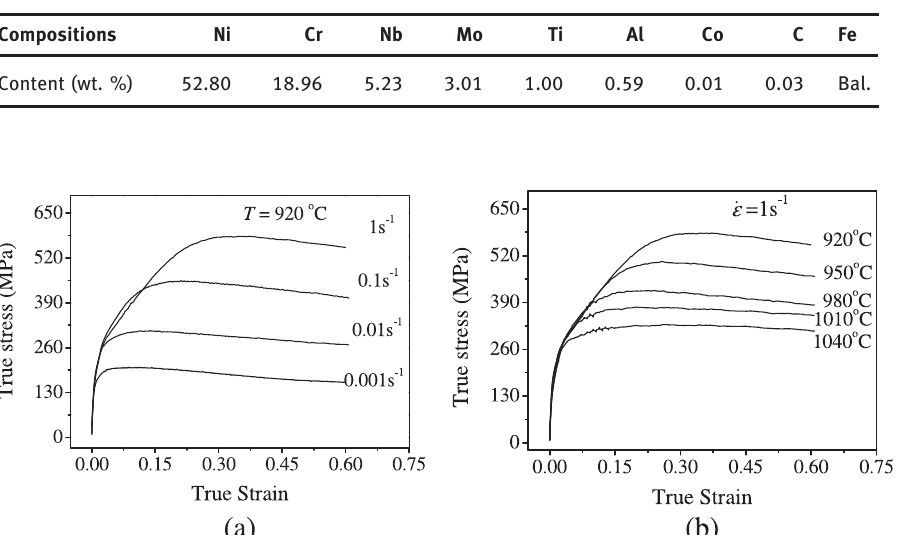
Figure 1: Typical illustrated true stress – strain curves of the studied superalloy at: (a) T = 920 °C and (b) _ ε =1s − 1